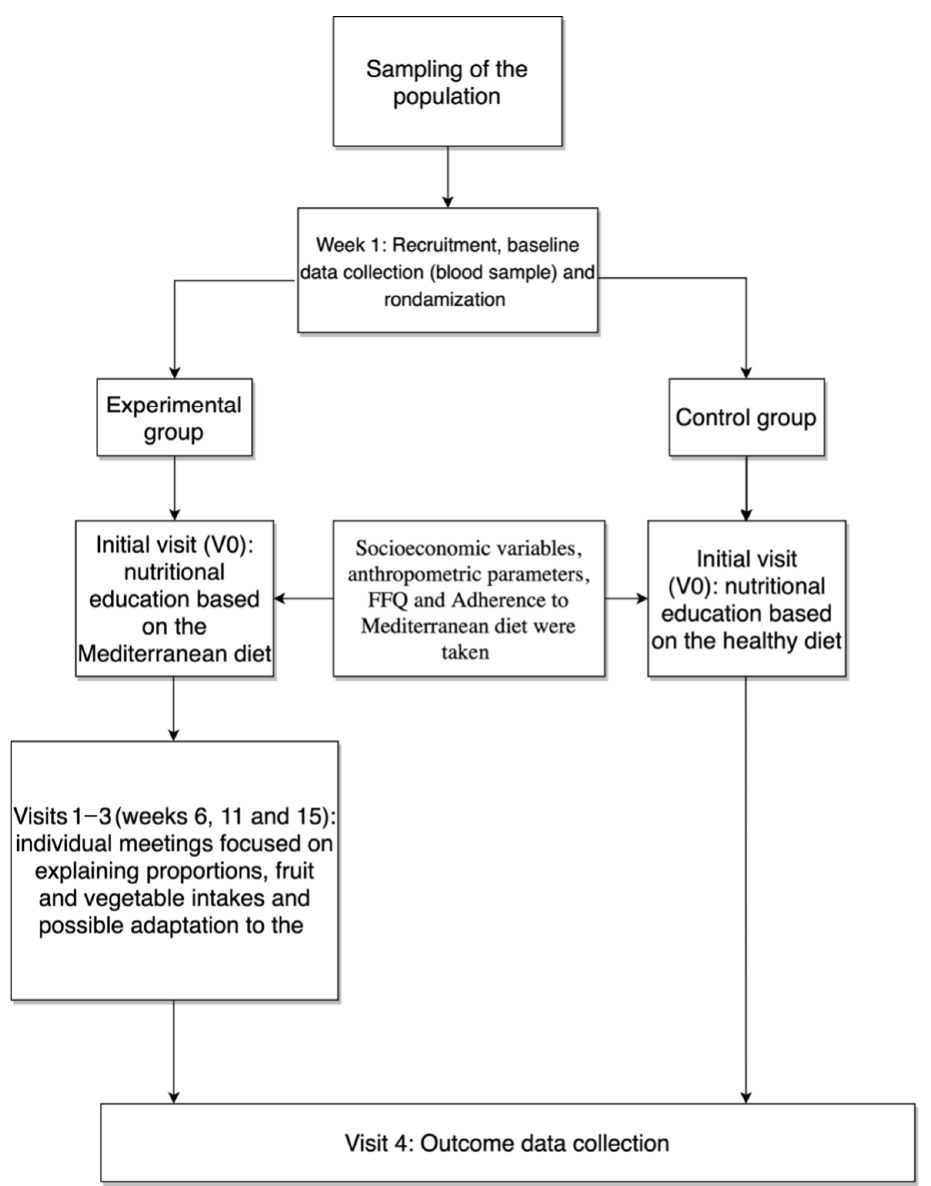
Figure 2. Flow chart of the nutritional intervention, visit follow-ups, and outcome data